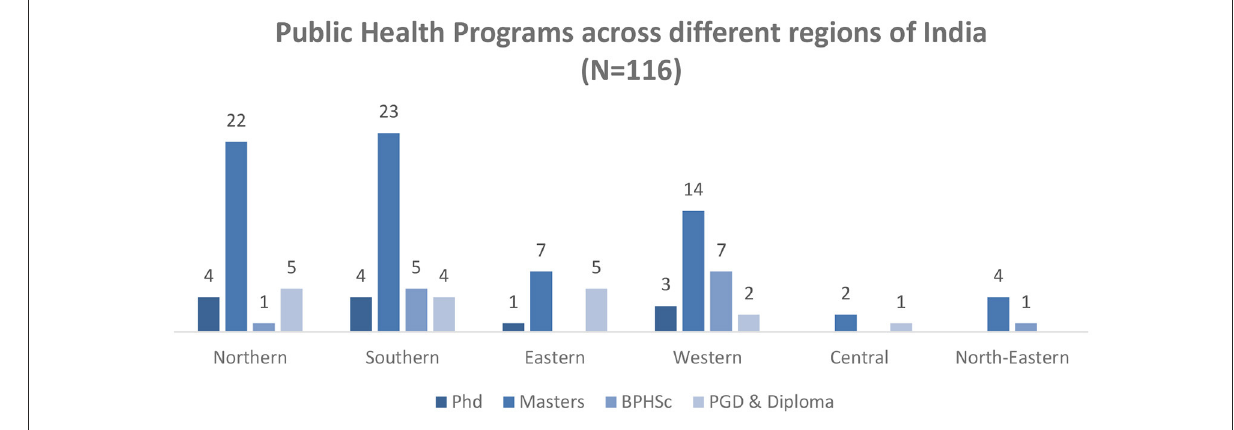
FIGURE4 Distribution of public health programs across different regions in